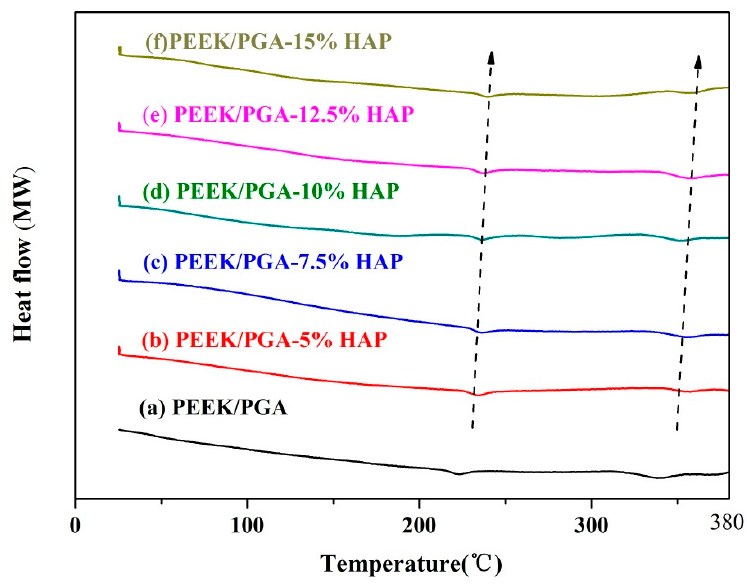
Figure 4. Differential scanning calorimetry (DSC) spectra of PEEK/PGA scaffold and PEEK/PGA-HAP composite scaffolds.